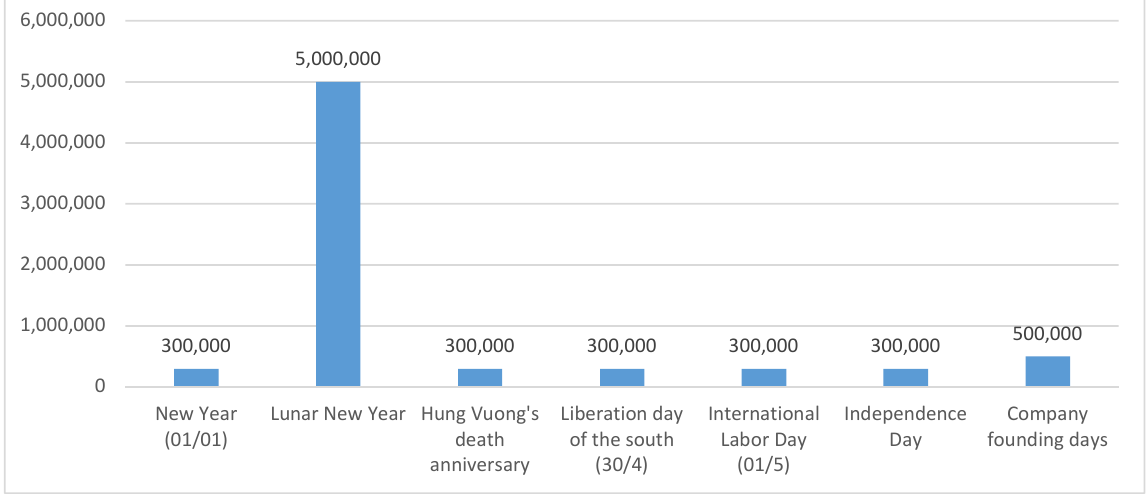
Fig. 4. Bonus payment regulations (Unit: VND)